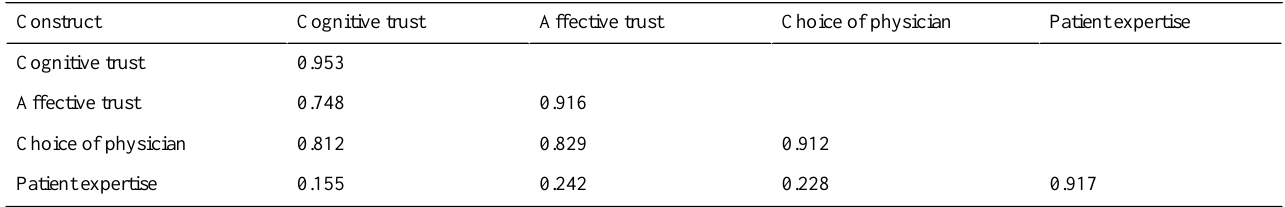
Table 5. Discriminant validity